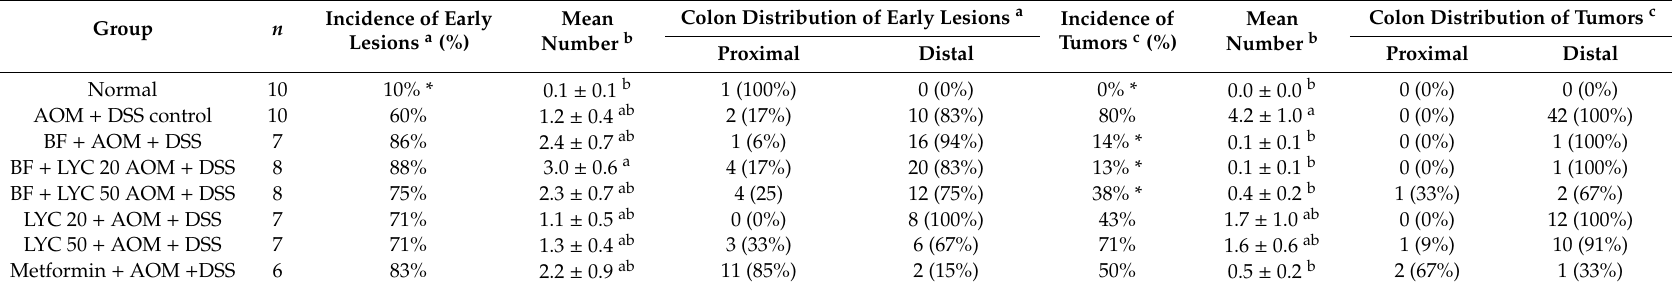
Table 2. Anticarcinogenic e ff ect of B. longum microencapsulates on the macroscopic quantitative classification of colonic lesions induced with AOM and DSS in male CD-1